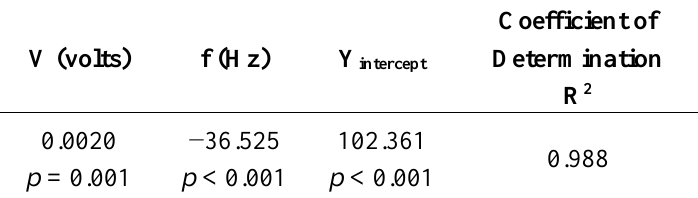
Table 11. Regression analysis for the damping parameter  .